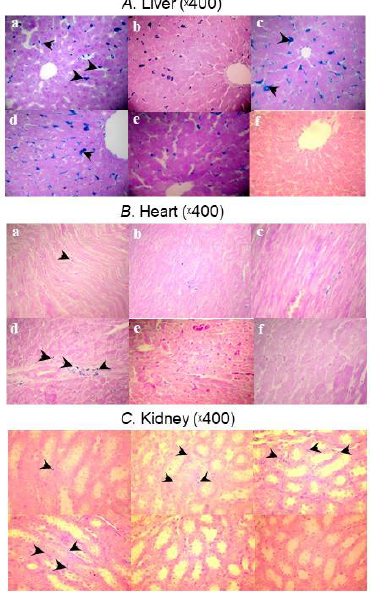
Figure 2. Micrographs showing Prussian blue staining for iron deposits in ( A ) liver, ( B ) heart, and ( C ) kidney samples taken from the HMW iron dextran (a), LMW iron dextran (b), ferric gluconate (c), ferric carboxymaltose (d), iron sucrose (e), and control (f) groups on Day 29 [48].